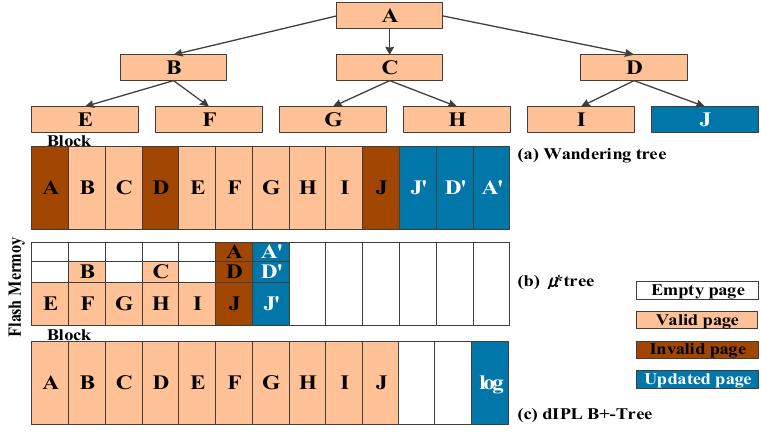
Figure 4. Structure-modified B-Trees for flash memory.